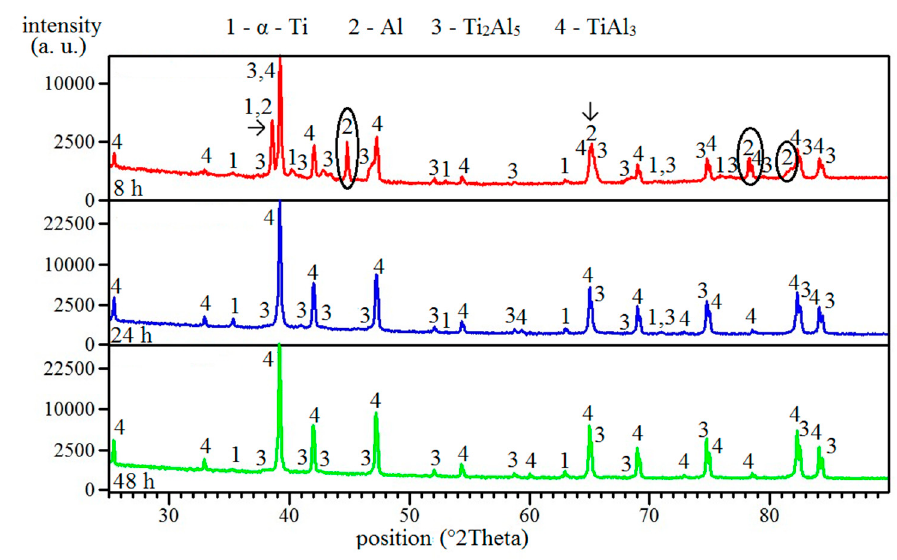
Figure 8. The microstructure of TiAl63 alloys annealed at 600 °C for ( a ) 8 h, ( b ) 24 h, and ( c ) 48 h.